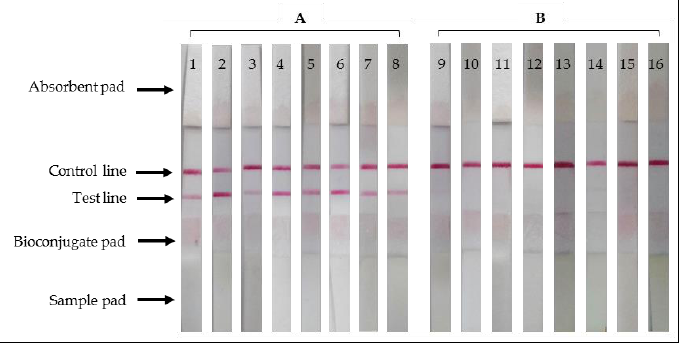
Figure 2. ICT strips used for detection of antibodies to B. bovis : examples after applying ( A ) positive and ( B ) negative reference bovine serum samples. Lanes 1–8, positive result for detection of antibodies to B. bovis (colored bands at control and test lines); lanes 9–16, negative result (colored band at control line). Table 2. Results of the ELISA, ICT and IFAT for detection of antibodies to B. bovis in field serum samples.